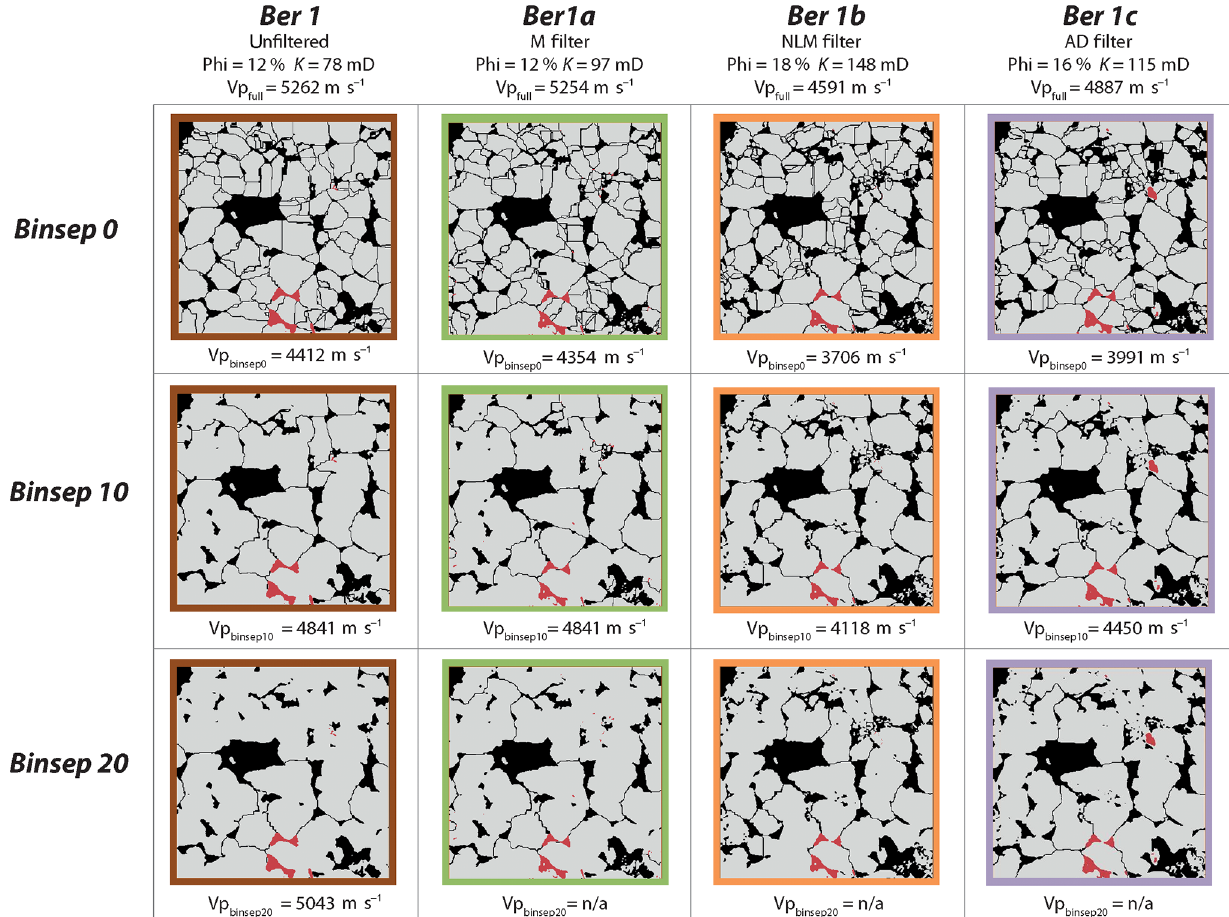
Figure 12. This figure comprises the results of the preliminary study on the effect of filtering on the modeling of effective elastic properties. Representative 2-D slices (#111 of the X – Y plane) are depicted.